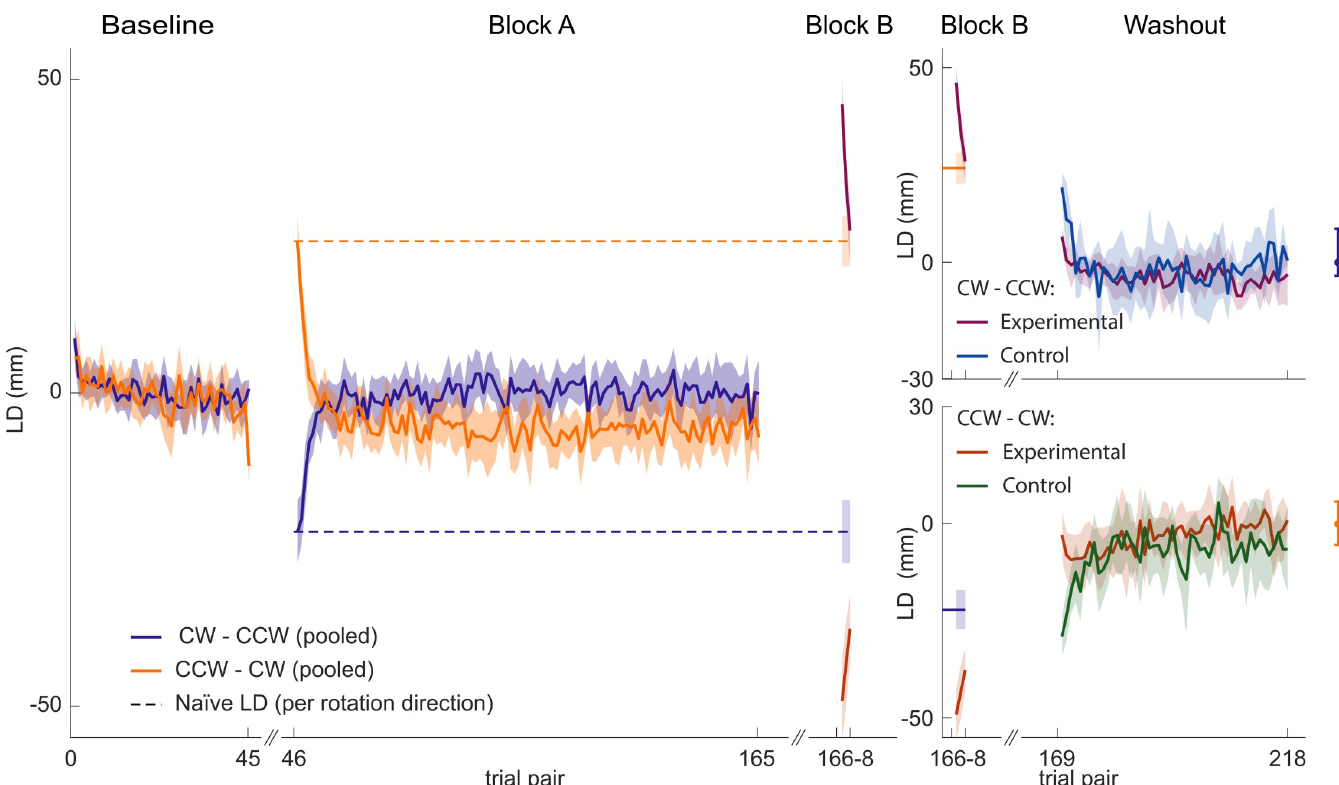
Fig 3. Lateral deviation as a function of trial pair number. CW-CCW (purple, pink and blue lines) and CCW-CW (orange, dark orange and green lines) group. Baseline and block A: grand-average of all trials of control and experimental group (orange and purple). Block B and washout: control (green and blue) and experimental group (pink and dark orange) plotted separately. Baseline fluctuations are indicated to the right of the washout phase by the mean, maximum and minimum of the mean baseline levels.